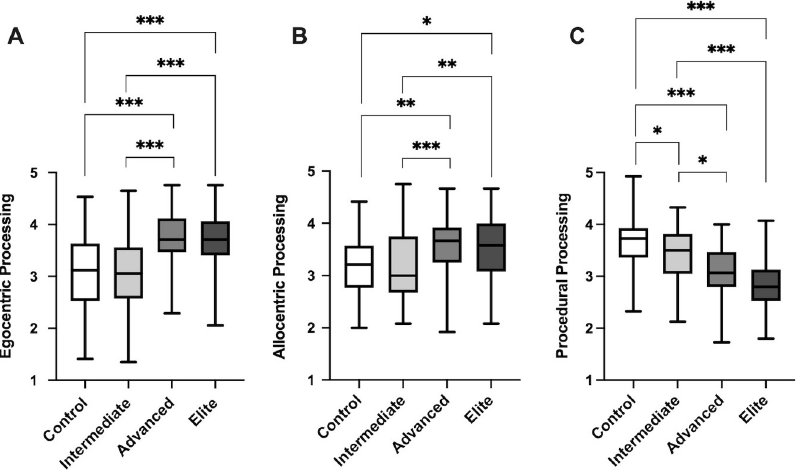
Fig 1. Average score on NSQ spatial processing measure across groups. A boxplot demonstrating mean, minimum, and max values for A) egocentric spatial processing, B) allocentric spatial processing, and C) procedural processing. Error bars reflect SD. � reflects p < .05, �� reflects p < .01, ��� reflects p < .001.